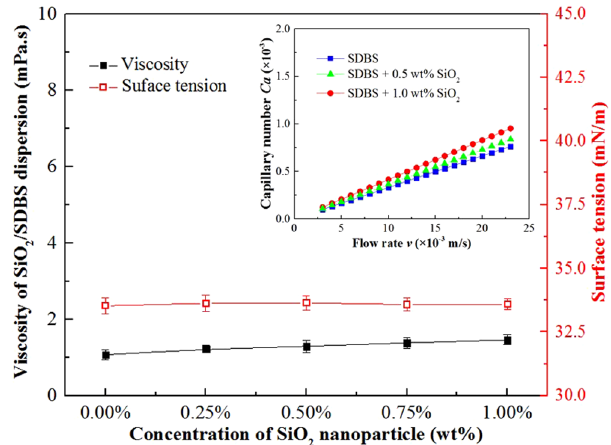
Figure 4. Effect of SiO 2 nanoparticles on the liquid viscosity μ , surface tension σ and capillary number Ca of SiO 2 /SDBS foam at 25 °C. The concentration of SDBS is 1.0 wt%; the shear rate was 100 s − 1 during viscosity